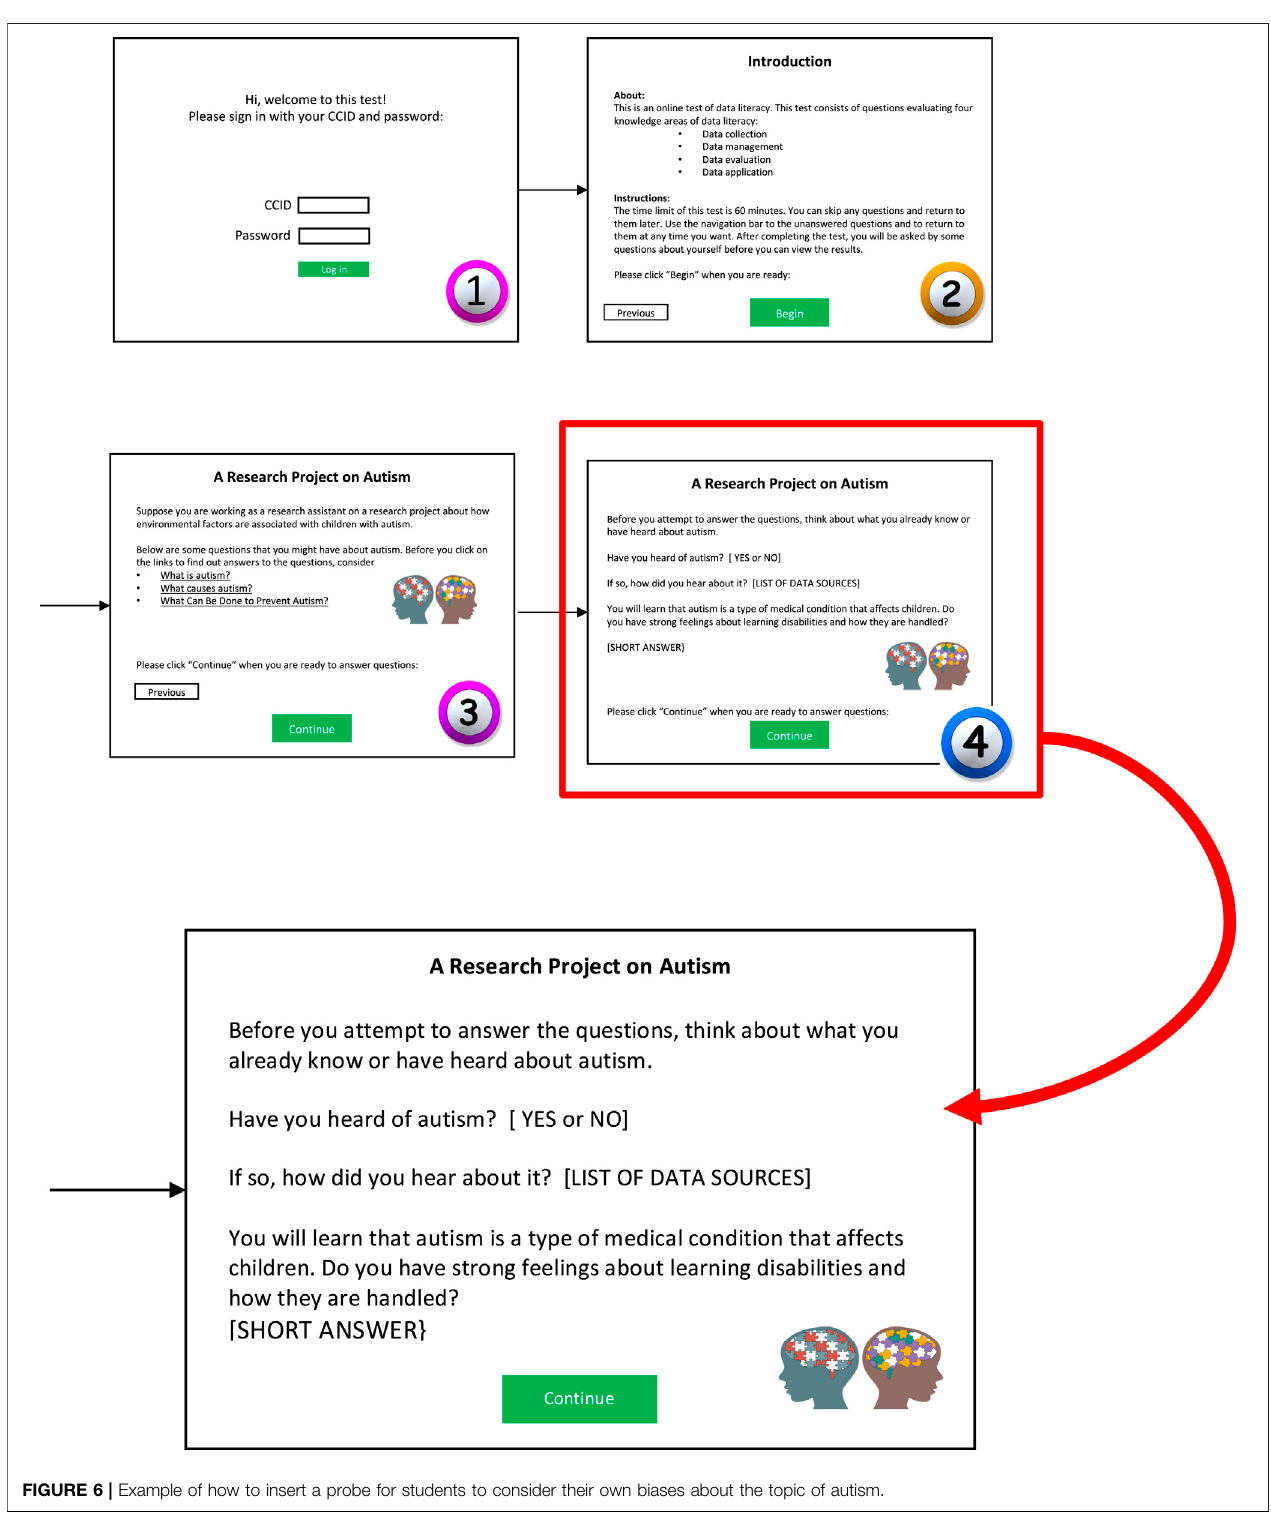
FIGURE 6 | Example of how to insert a probe for students to consider their own biases about the topic of autism.